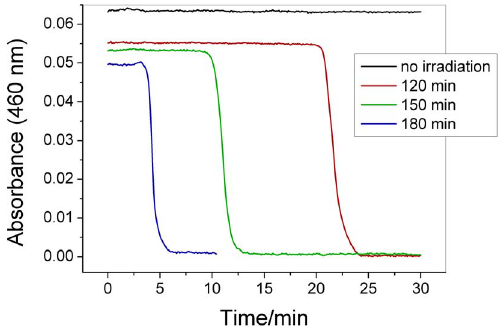
Figure 1. Effect of the iodine solution irradiation time on the clock time of the chlorate-iodine clock reaction. A 2.0 6 10 2 4 mol L 2 1 iodine solution was irradiated using the deuterium lamp of a diode array spectrophotometer during the indicated time. The reaction was followed at 460 nm using a conventional double-beam spectropho- tometer. The initial concentrations after mixing the reactants in the cuvette were as follows: [NaClO 3 ]=0.0251 mol L 2 1 , [HClO 4 ]=0.948 mol L 2 1 , and [I 2 ]=7.3 6 10 2 5 mol L 2 1 . The reactants were added to the solutions in the following order: NaClO 3 , irradiated iodine solution, water, and HClO 4